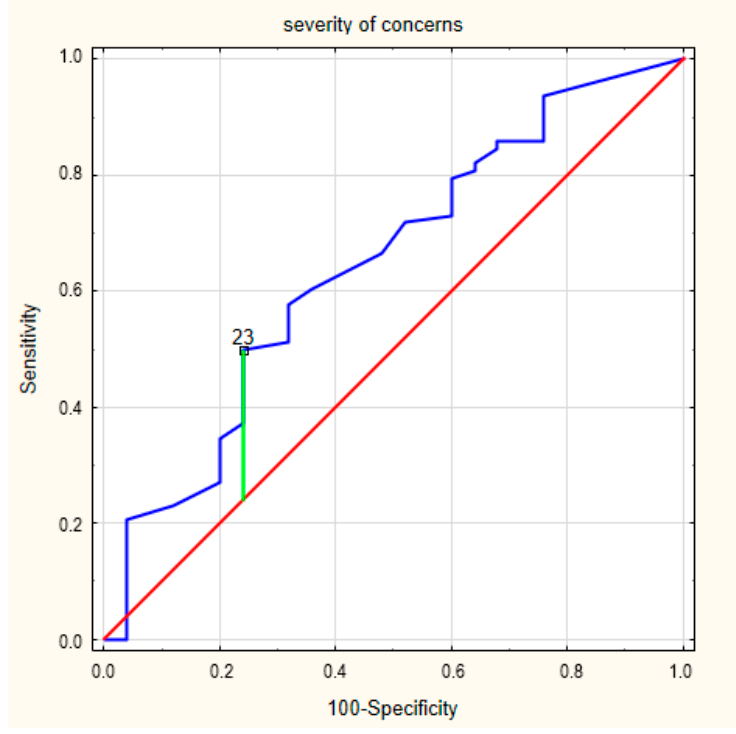
Figure 3. The ROC curves for the severity of the concerns in frailty syndrome.